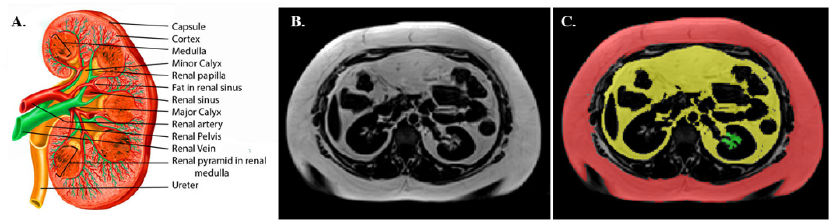
Figure 4. Sketch of the renal anatomy (Source: [29] distributed under the terms of the Creative Com- mons Attribution 4.0 International License (http://creativecommons.org/licenses/by/4.0/, accessed on the 6th of May 2022) © 2022, StatPearls Publishing LLC, ( A ). Representative examples of an MRI ( B ) and RSF measurement (green), SAT (red) and VAT (yellow) volume ( C ). For RSF, a single MRI slice approach was followed. RSF was manually traced, excluding the renal artery and vein from the RSF measurements.